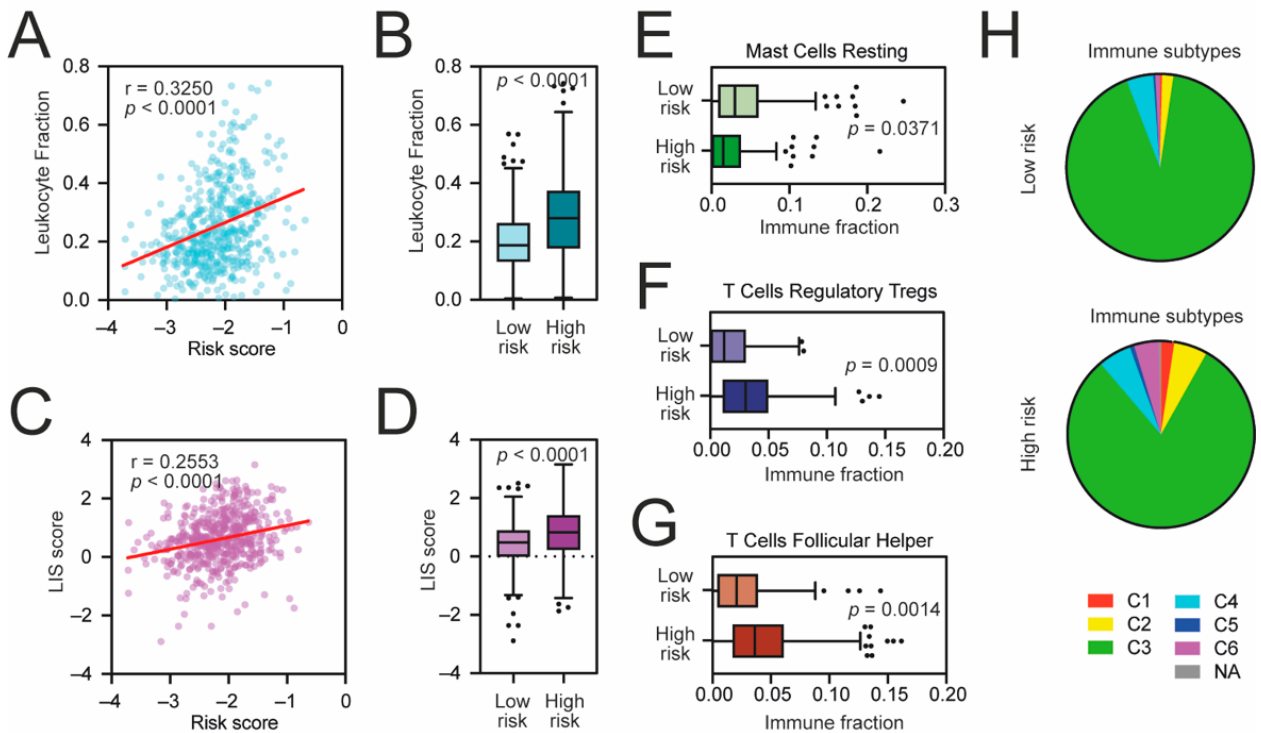
Figure 5. The immune landscape of high-risk KIRC tumors. ( A ) The Spearman correlation of the leukocyte fraction and KRAB-ZNF-based risk score in TCGA KIRC patients. ( B ) Tukey box plots of the leukocyte fraction in low-risk and high-risk KIRC patients. ( C ) The Spearman correlation of the lymphocyte infiltration signature (LIS) score and KRAB-ZNF-based risk score in TCGA KIRC patients. ( D ) Tukey box plots of the LIS score in low-risk and high-risk KIRC patients. ( E – G ) Tukey box plots of CIBERSORT-estimated fractions of ( E ) resting mast cells, ( F ) regulatory T cells, and ( G ) follicular helper T cells in low-risk and high-risk KIRC patients. ( H ) Classification of low-risk and high-risk KIRC tumors into C1–C6 immune subtypes [25]. Red—C1, wound healing; yellow—C2, IFN- γ dominant; green—C3, inflammatory; light Blue—C4, lymphocyte depleted; dark blue—C5, immunologically quiet; purple—C6, TGF- β dominant; Grey—not applicable.